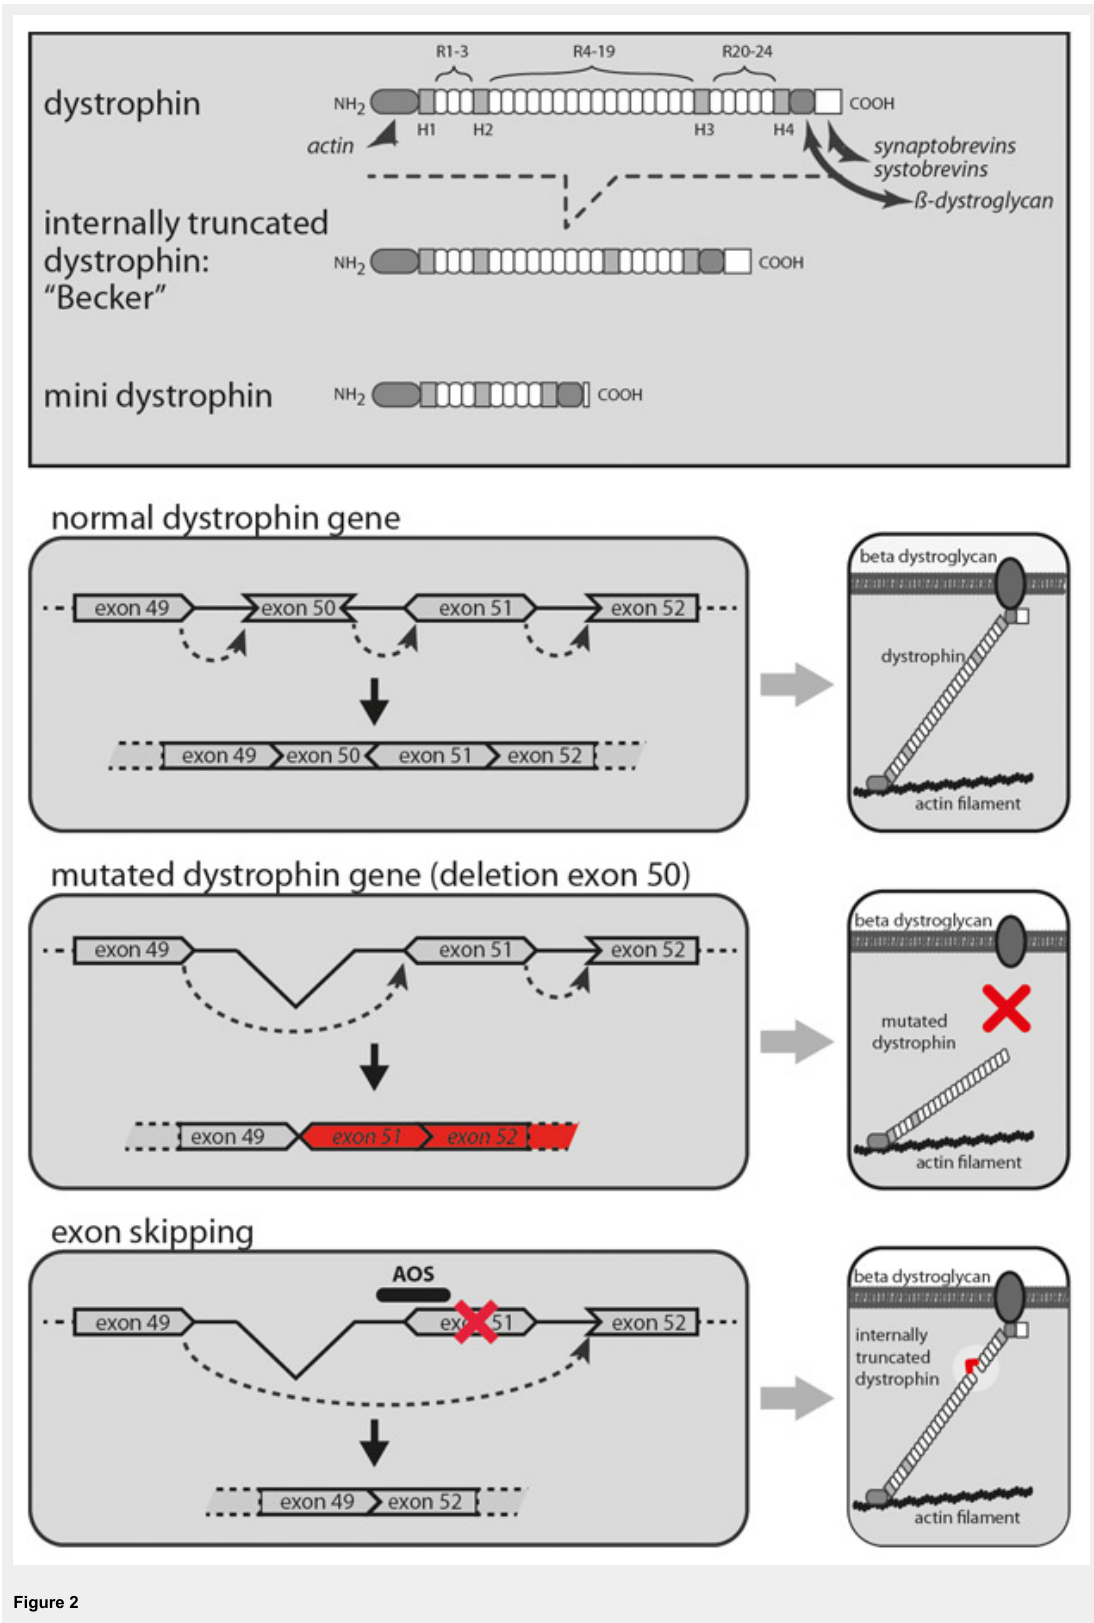
Figure 2 Exon skipping as a therapeutic strategy for the treatment of Duchenne muscular dystrophy. During splicing of the dystrophin pre-mRNA the introns are removed and exons are joined to build mRNA with a reading frame to allow synthesis of functional dystrophin proteins. In the case of exonic deletions, “out of frame” mRNA can be produced, inducing premature termination of protein translation. This leads to a nonfunctional dystrophin protein, rapidly removed by the cellular degradation machinery. An exon skipping strategy is applied to restore the reading frame. By use of antisense oligonucleotides targeting splice sites of the pre-mRNA, one or more exons are removed to correct the reading frame. This results in a shortened but partially functional dystrophin